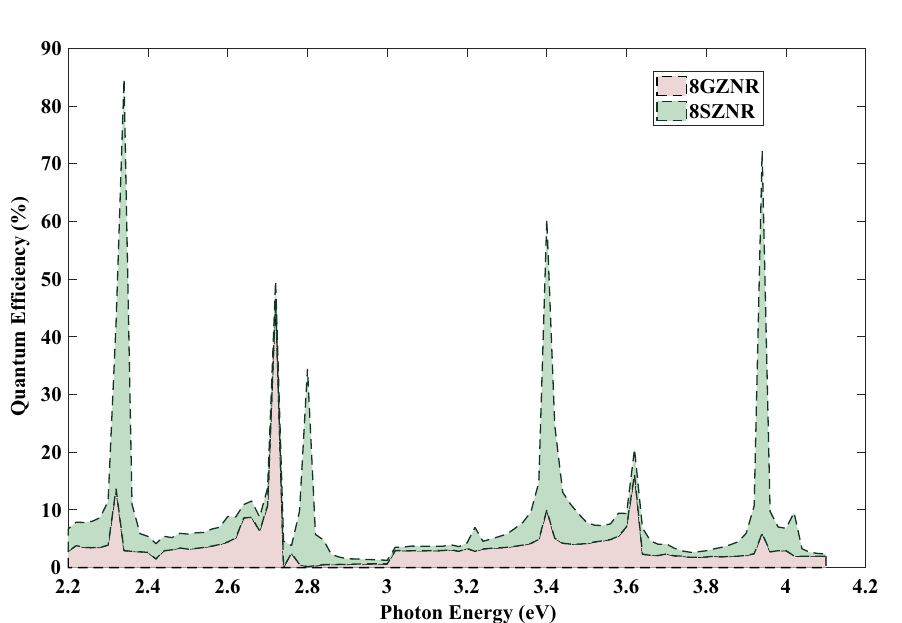
Figure 5. The band structure of 8 ZGNR subject to a perpendicular electric field with elE z denotes spin down and dashed red line denotes spin up.